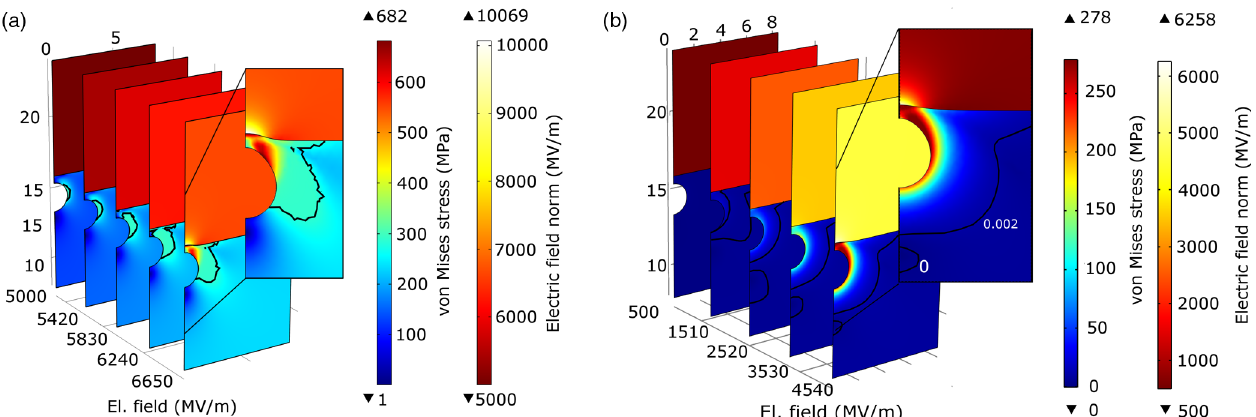
FIG. 4. Plastic deformation of the surfaces of the stainless steel (a) and the annealed copper (b) simulations cells near the void with the aspect ratio h=r ¼ 0 . 5 . The high Young ’ s modulus and low linear strain hardening lead to well-defined protrusion development in the case of the stainless steel. The soft properties of copper surface lead to plastic deformation of the whole simulated sample while its significant strain hardening hinders the evolution of the